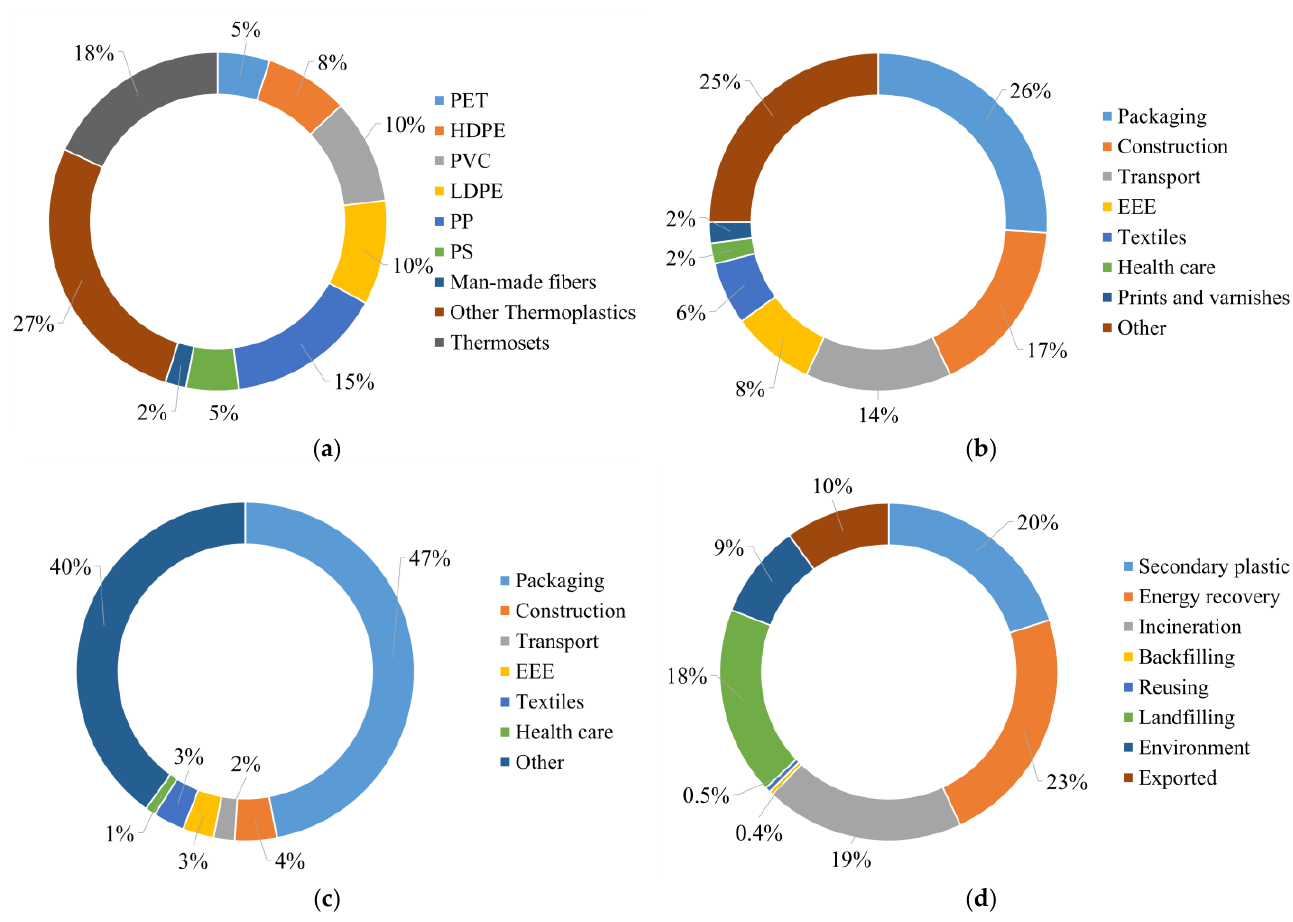
Figure 1. Plastics flows in the EU (2016): ( a ) production; ( b ) product consumption; ( c ) waste gener- ation; ( d ) destination of waste. Elaborated from data presented by Hsu et al. [51]. PCPW (36,592 kt in 2016) can be divided into seven different flows (Figure 1c): pack- aging (16,122 kt), construction materials (1537 kt), transport waste (777 kt), EEE (984 kt), textiles (1101 kt), healthcare waste (233 kt), and “other” (13,601 kt). Plastic waste from man- ufacturing processes and from packaging products (in use for one year or less)